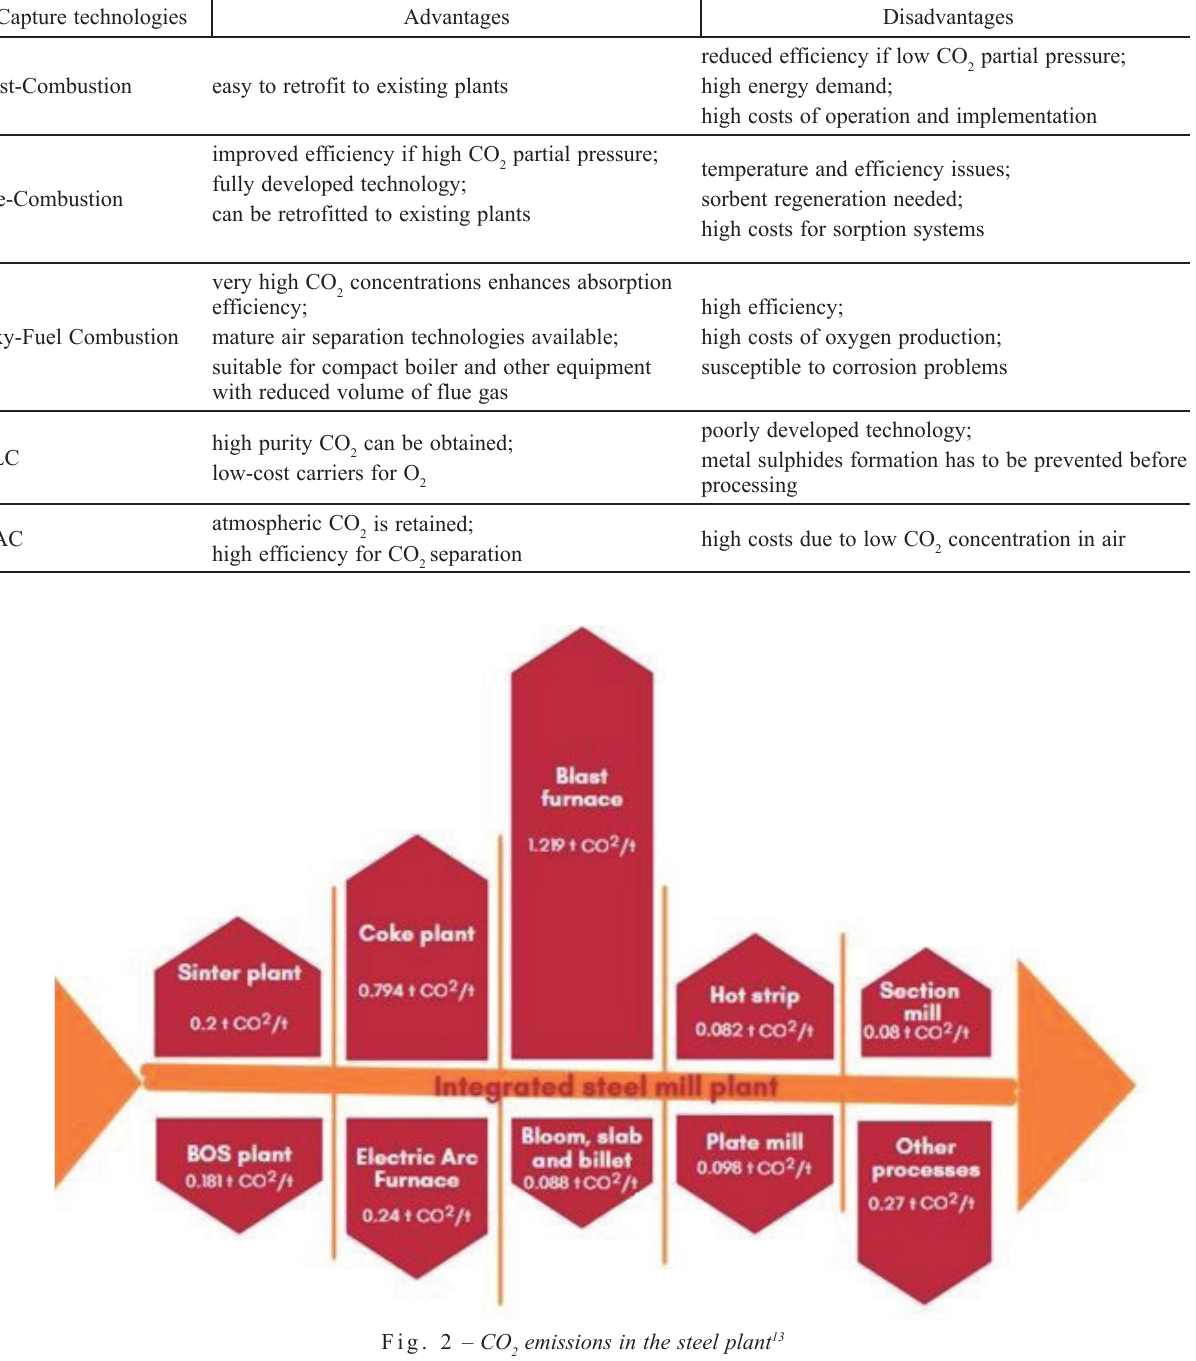
capture technologies 2